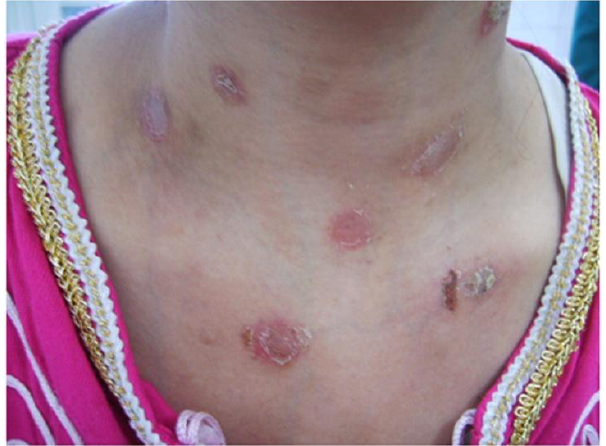
Figure 1: Multiple and ruptured bullous lesions of the neckline and